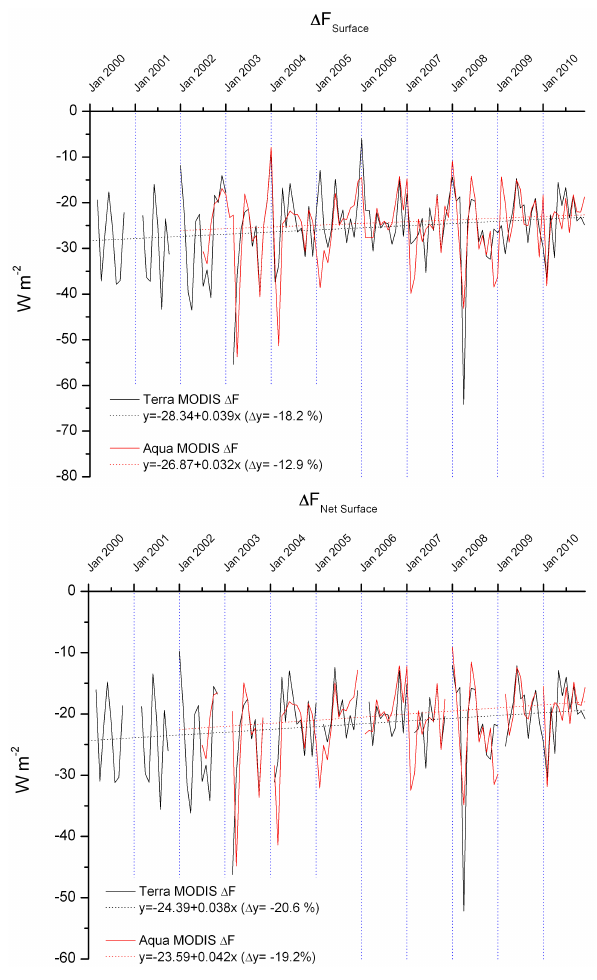
Fig. 9. Time series of the monthly mean aerosol DRE at the sur- face (incident (a) and absorbed (b) radiation), as computed from the model, based on Terra and Aqua MODIS Level 2 data, for the period 2000–2010, at the HCMR station, Crete. The applied linear fits to the time series are also shown (dotted